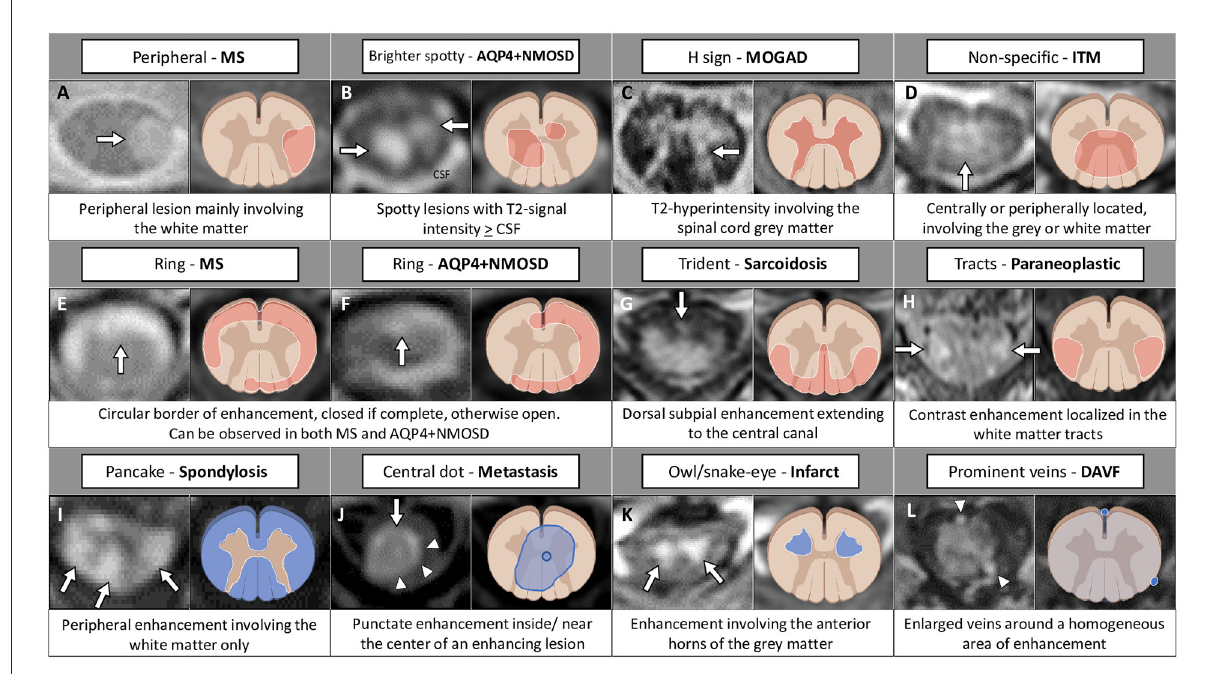
FIGURE4 MRI and corresponding schematic representation of key findings on axial view of inflammatory myelopathies and their mimics. Each finding, labeled by a letter (A–L) , is shown on the most appropriate magnetic resonance imaging sequence (e.g., T2-weighted image in the top row; post-contrast T1-weighted image in the bottom rows), a brief description is provided. Red color indicates inflammatory myelopathies, while blue color indicates their mimics. The figure was created with BioRender.com. The arrowheads in (J) highlight a peripheral area of enhancement surrounding the central dot sign; in (L) indicate two veins visible around the area of enhancement. AQP4 + NMOSD, aquaporin-4-IgG-positive neuromyelitis optica spectrum disorders; CSF, cerebrospinal fluid; DAVF, dural arteriovenous fistula; ITM, idiopathic transverse myelitis;